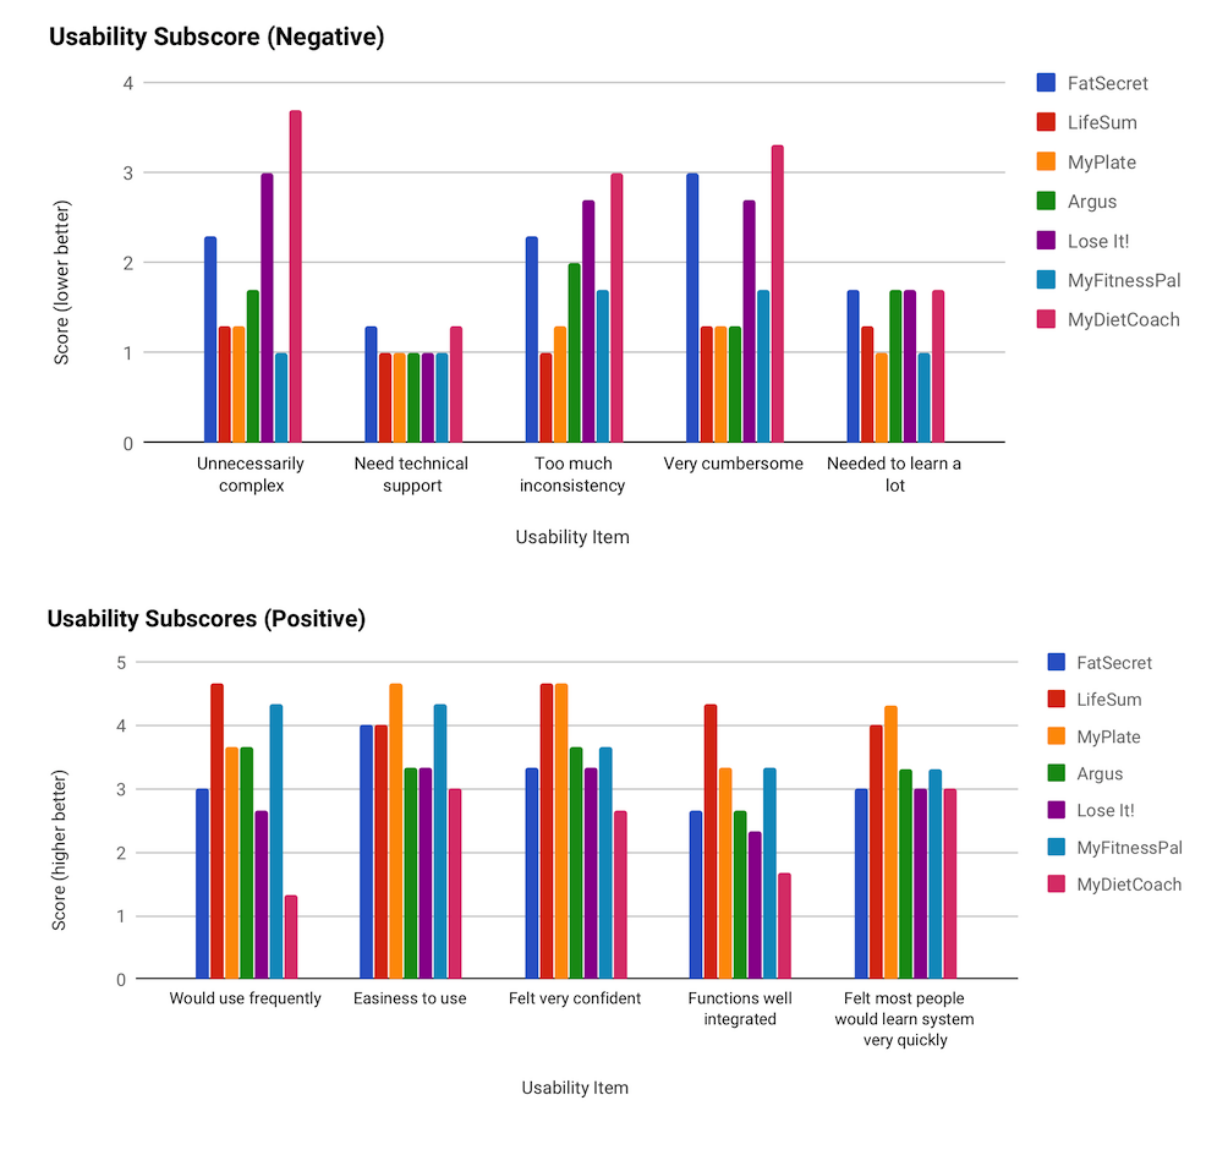
Figure 1. Positive items (top) and negative items (bottom) of